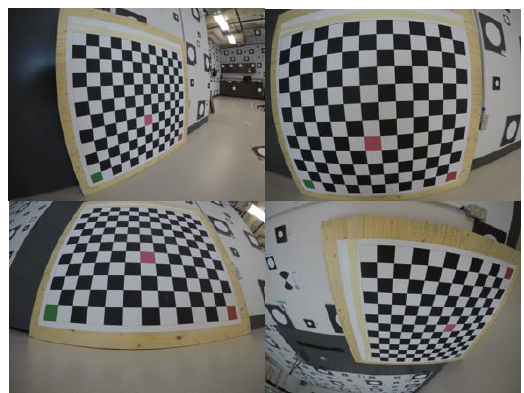
Figure 6. Sample of checkboard target calibration imagery.